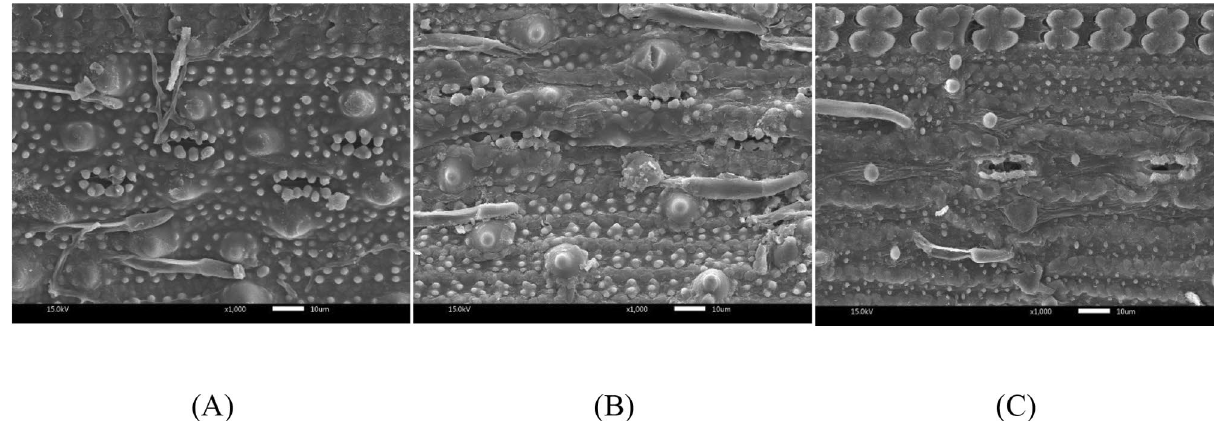
Figure 1. Rice straw surface morphology at × 1000 ( A ) Untreated rice straw, ( B ) Rice straw treated with 0.1 N H 2 SO 4 for 4 h, ( C ) Rice straw treated with 0.1 N NaOH for 4